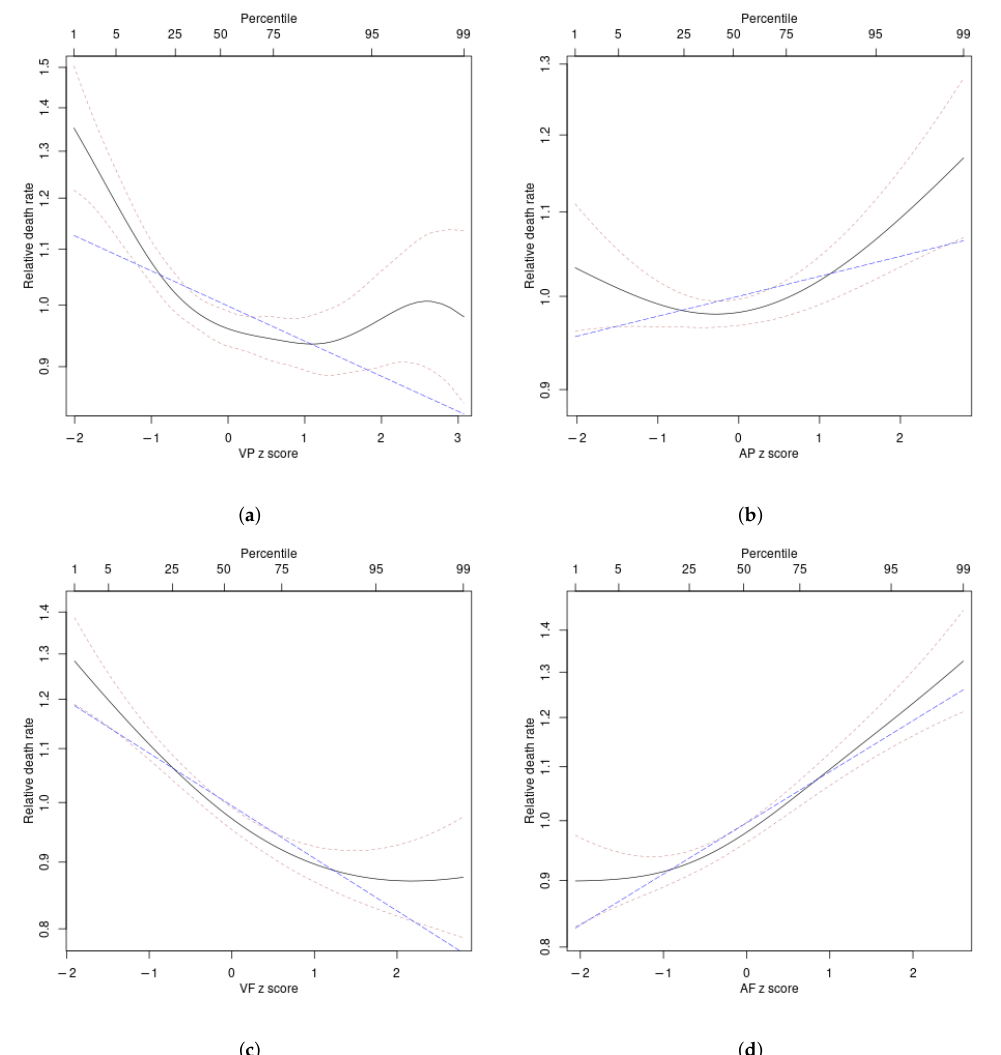
Figure 3. Estimated mortality hazard ratios in ARIC as nonlinear (penalized spline) functions of fraction of calories from vegetable and animal sources: ( a ) plant protein (VP), ( b ) animal protein (AP), ( c ) vegetable fat (VF), ( d ) animal fat (AF) (solid curves). Thin dashed curves indicate 95% confidence intervals. The blue long-dashed line shows the corresponding best linear fit, which can be seen to in some cases not capture well the underlying nonlinear